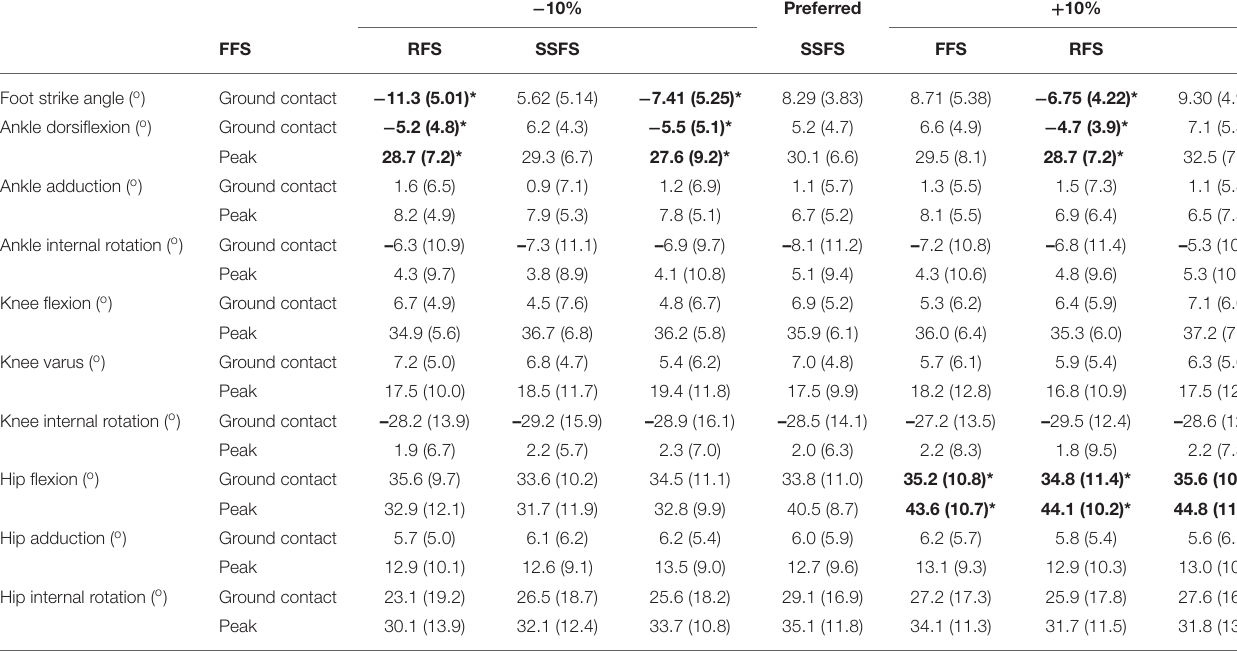
TABLE 2 | Mean (SD) values for lower extremity kinematics at ground contact and peak values for the preferred and manipulated stride length and foot strike trials. − 10%